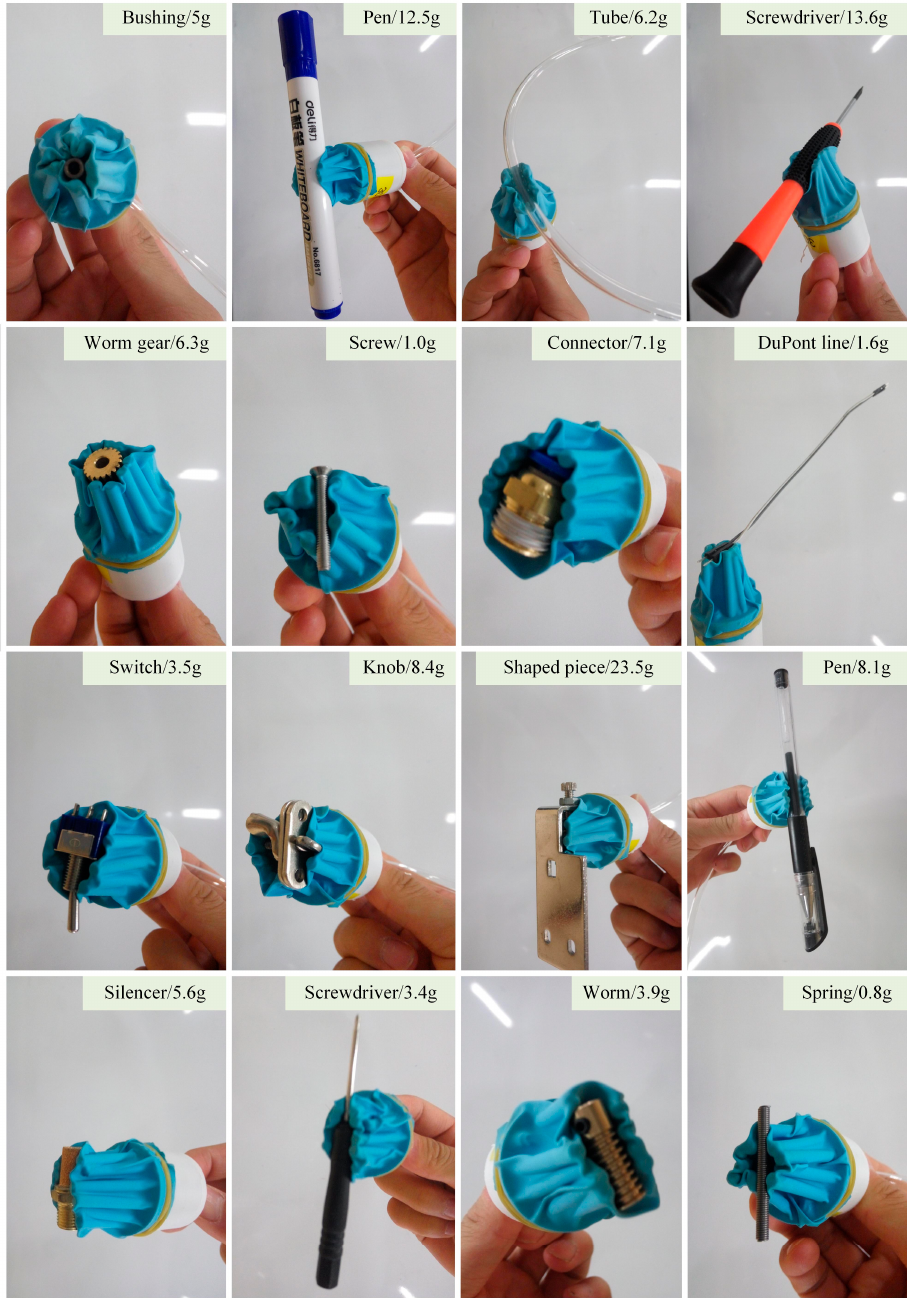
Figure 16. The experiments with the verification of the crawl function.